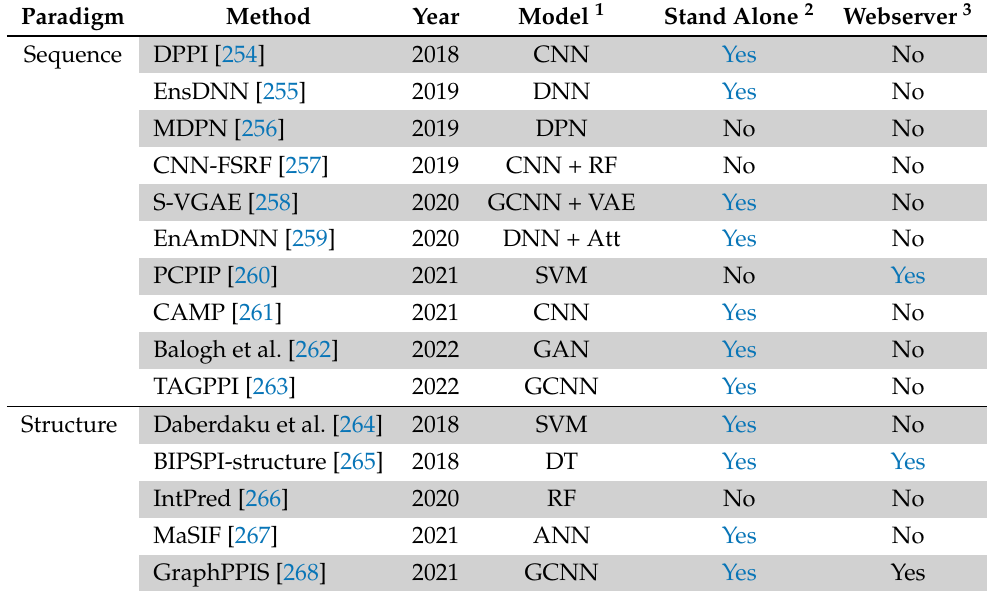
Table 3. Machine learning methods for PPI prediction from 2018 to